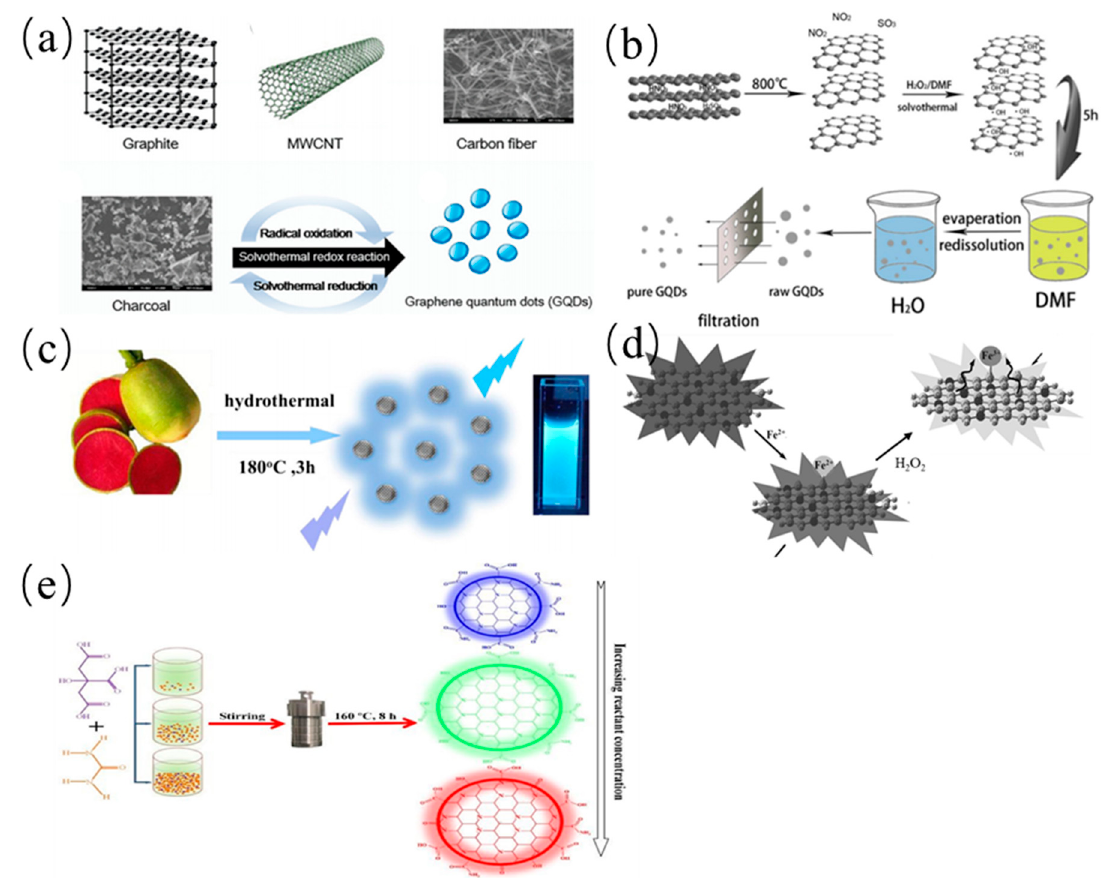
Figure 7. Schematic diagram of ( a ) solvothermal exfoliation of different carbon-based precursors to synthesize the fluorescence CQD [97]. Copyright 2015, Royal Society of Chemistry. ( b ) Synthesis of the CQDs from graphite in DMF solution [98]. Copyright 2018, Elsevier. ( c ) Synthesis of N-CDs from rose-heart radish [99]. Copyright 2017, Elsevier. ( d ) Schematic of the sensing mechanism for H 2 O 2 detection based on NCQDs and Fe 2+ [100]. Copyright 2014, John Wiley and Sons. ( e ) Synthesis mechanisms for full-color emitting CQDs [102]. Copyright 2020, Royal Society of Chemistry.